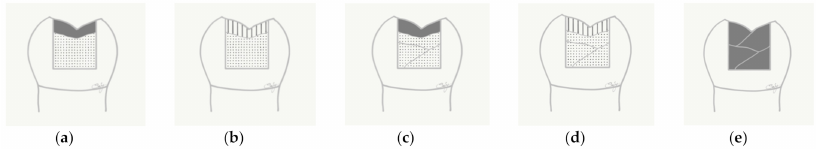
Figure 1. Schematic figure representing the test groups (from left to right). ( a ) Group 1: flowable SFRC bulk and conventional packable composite; ( b ) Group 2: flowable SFRC bulk and conventional flowable composite; ( c ) Group 3: flowable SFRC layered and conventional packable composite; ( d ) Group 4: flowable SFRC layered and conventional flowable composite; ( e ) Control Group: conventional packable layered